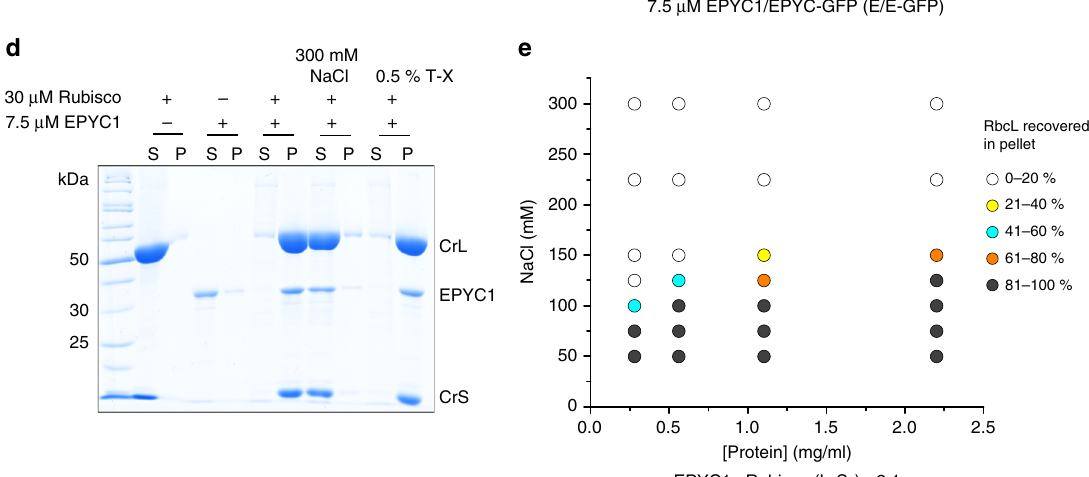
Fig. 1 Rubisco and EPYC1 are necessary and suf fi cient to bring about a liquid-liquid phase separation. a Addition of EPYC1 to Rubisco results in turbidity that clears over time. b The turbidity is caused by the formation of spherical droplets that are fl uorescently labeled when 5% EPYC1-GFP is included. Scale bar 15 µ m. c Droplets fuse by coalescence. Scale bar 5 µ m. d The droplets can be harvested by centrifugation (10 min, 21,100 × g ). e Protein demixing is protein and salt concentration-dependent. The phase diagram was generated by quantifying the proportion of RbcL found in the pellet fraction. All experiments were carried out in 20 mM Tris-HCl (pH 8.0) and 50 mM NaCl (buffer A) unless indicated